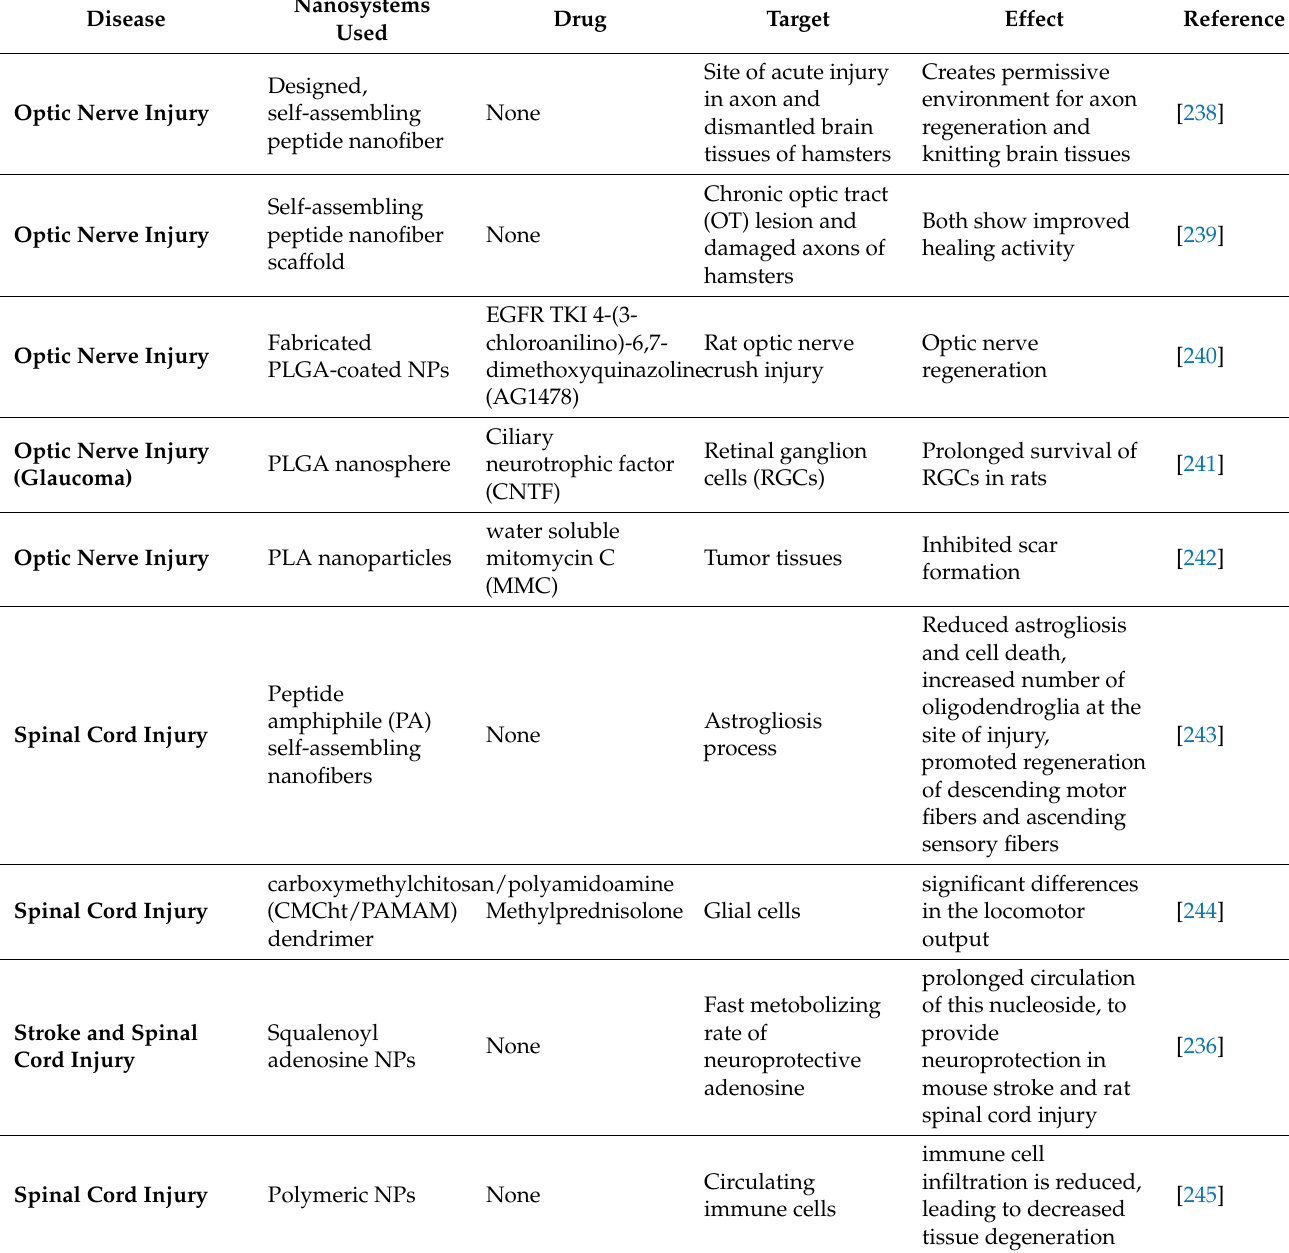
Table 3. Summary of the various nanosystems used for the treatment of central nervous system disorders.